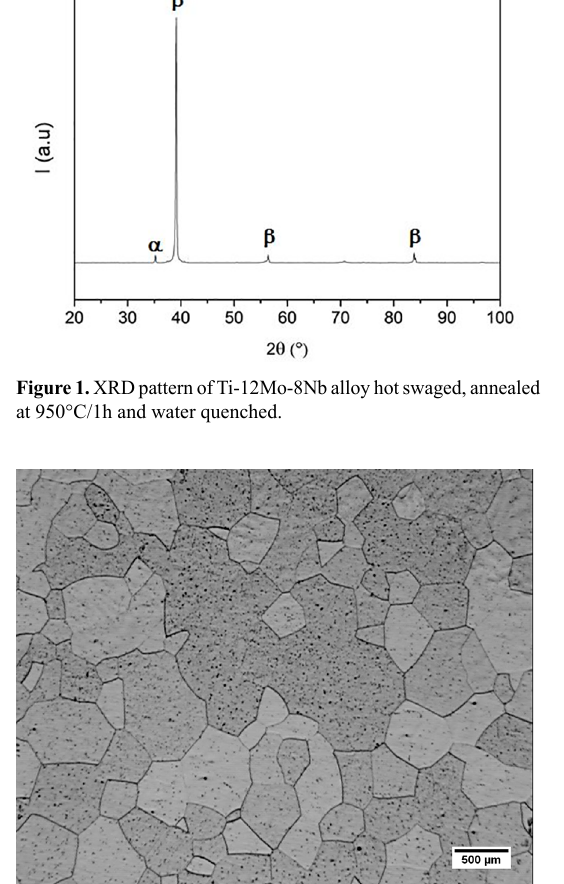
Figure 2. OM of Ti-12Mo-8Nb alloy hot swaged, annealed at 950°C/1h and water quenched.